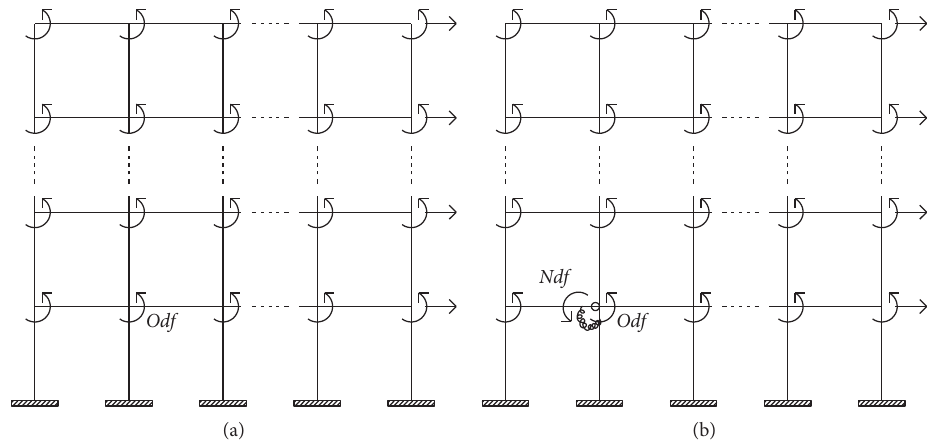
Figure 19: Odf and Ndf in case of the undamaged (a) and damaged (b)